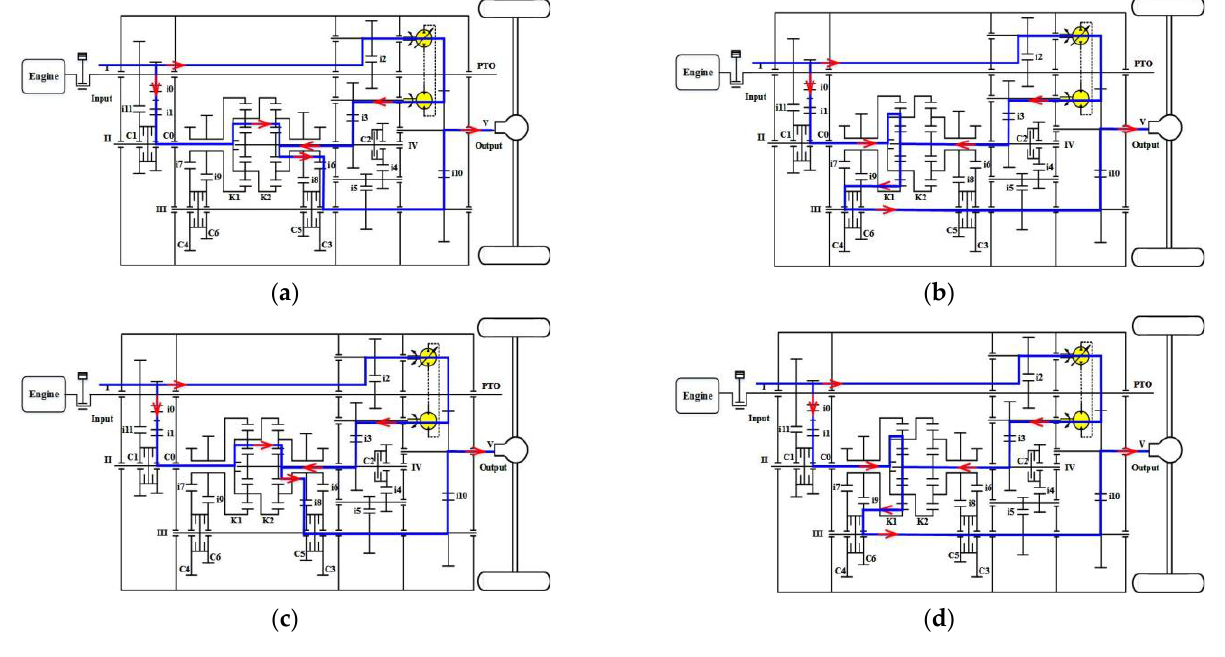
Figure 6. Power flow roadmap in HM x : ( a ) HM1; ( b ) HM2; ( c ) HM3 and ( d ) HM4. The HMCVT speed regulation characteristics are shown in Figure 7. The clutches C3, C4, C5 and C6 are controlled to complete the switching of each section in HM1, HM2, HM3 and HM4, so the continuous speed change between stages is realized. The displacement ratio e of the pump and the motor is controlled in order to achieve a continuous speed change in each stage.